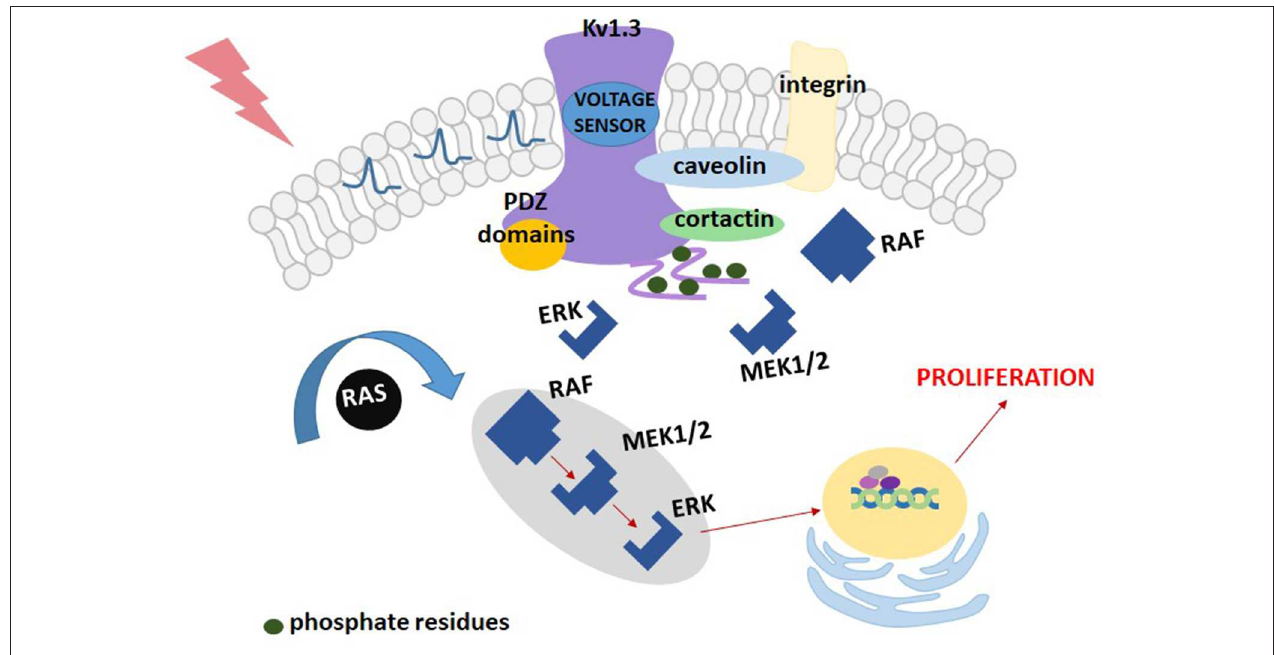
FIGURE 2 | A scheme of the “voltage sensor model” for the contribution of Kv1.3 channel to proliferation of Kv1.3-transfected HEK293